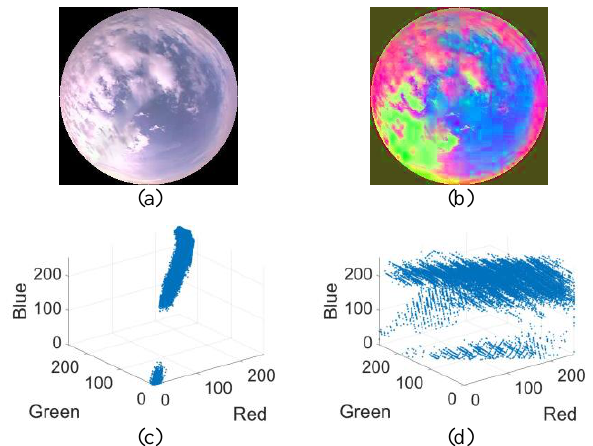
Figure 5. Comparison of DS result: (a) original image; (b) image after DS; (c) color scatterplot of (a); (d) color scatterplot of